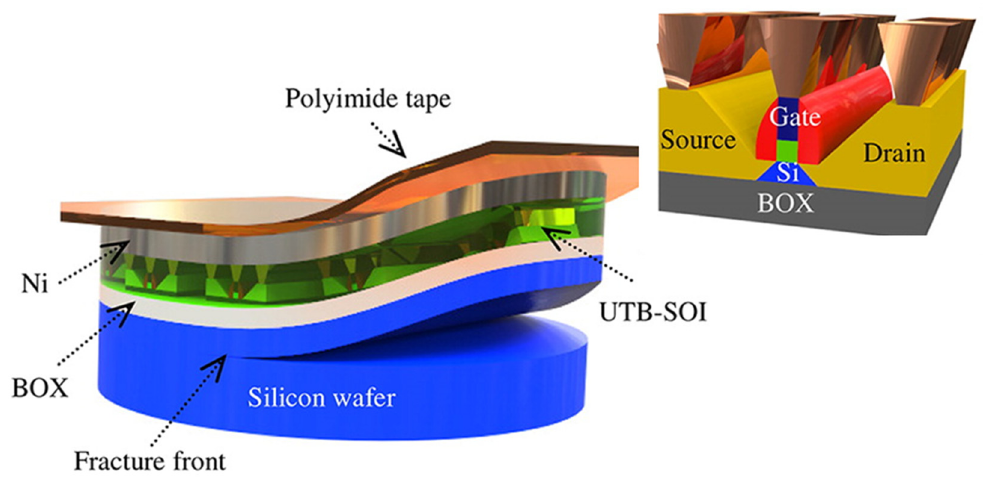
Figure 4. Schematic illustration of the controlled spalling process used for removing the prefabricated devices and circuits from the rigid silicon handle wafer. The inset schematically shows the device architecture for the ultra-thin body transistors with raised source/drain regions. Reprinted with permission from [37]. Copyright (2012) American Chemical